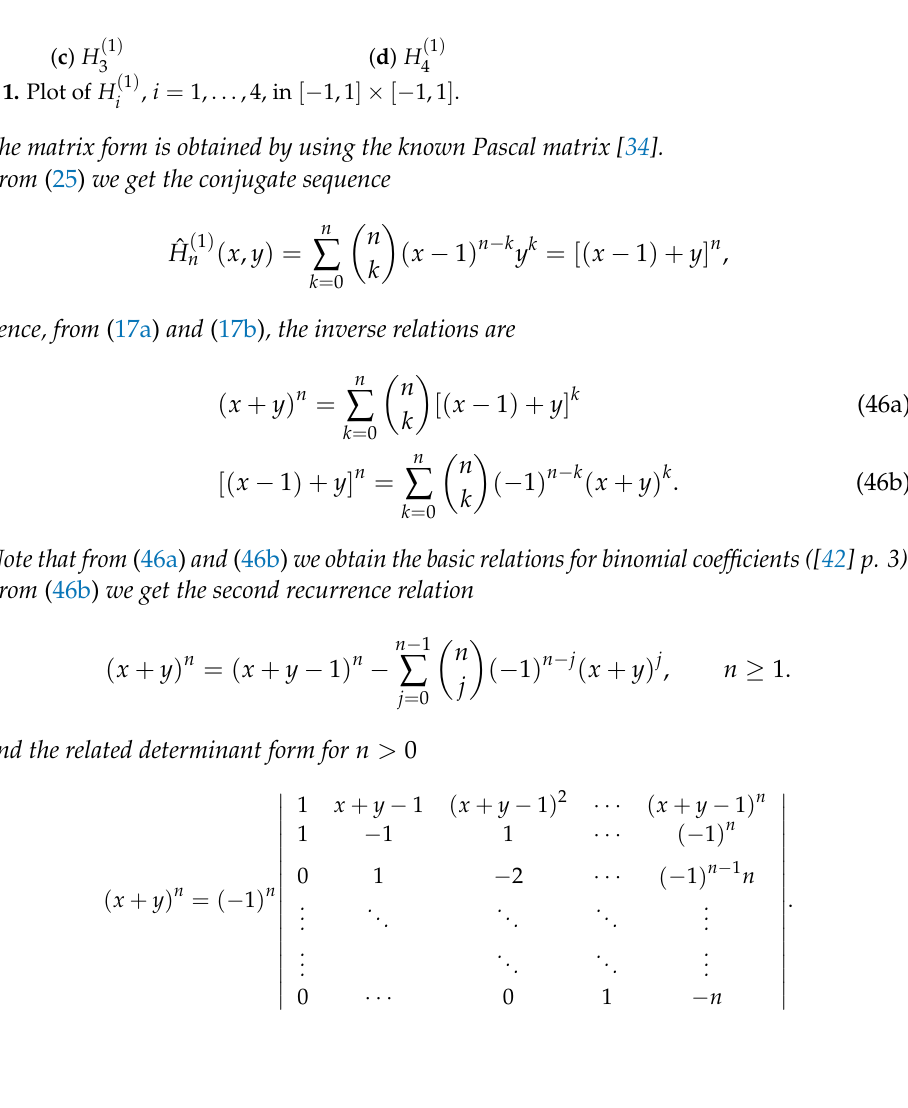
( 1 ) , i = 1, . . . ,4, in [ − 1,1 ] × [ − 1,1 ] i